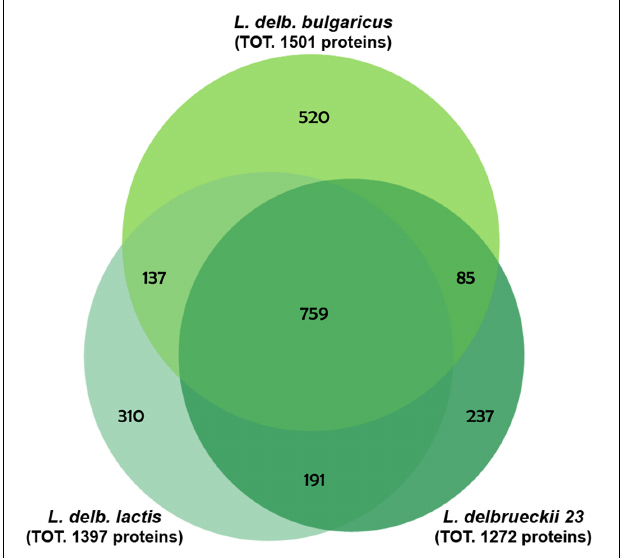
FIGURE 2 | Venn diagram of protein distribution across the analyzed strains. Proteins are identified from total cell extracts derived from lactobacilli grown overnight in Elliker